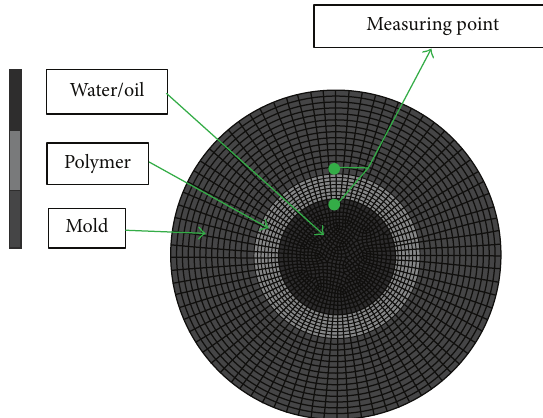
Figure 4: Definition of the heat transfer analysis model.